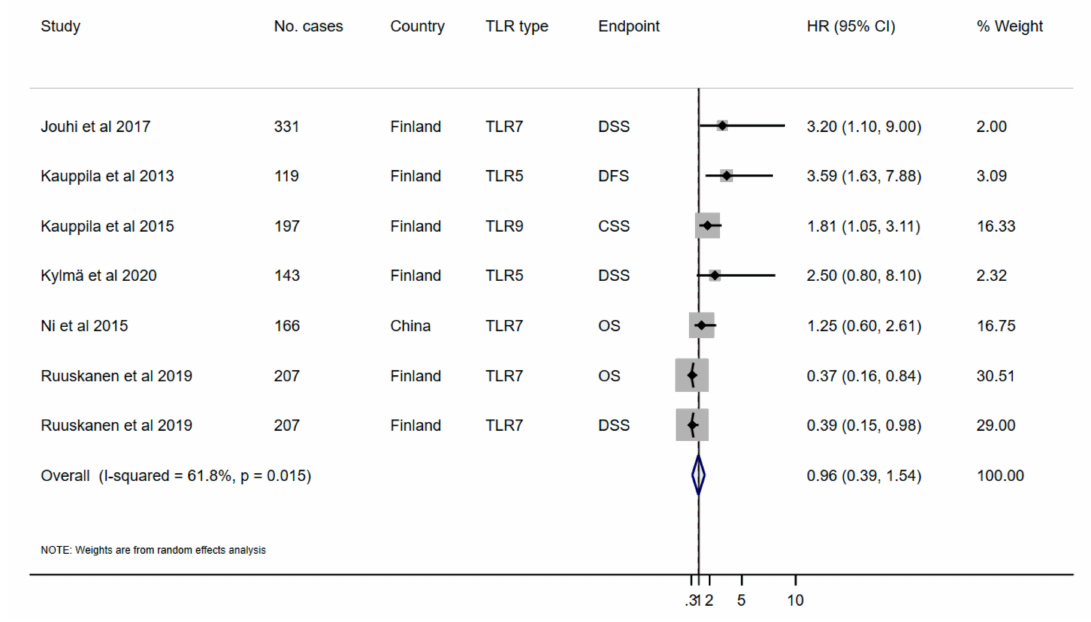
Figure 2. Forest plot of the association between toll-like receptors (TLR) and survival outcomes in HNSCC patients (random-e ff ects model). HR, hazard ratio; CI, confidence